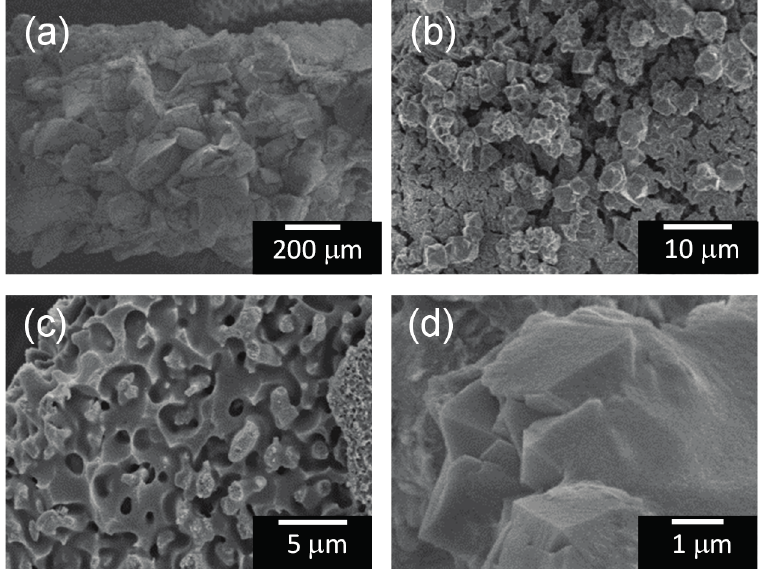
Figure 4. FE-SEM images of the TiO 2 -coated zeolite-porous glass composite: ( a ) low magnification image; ( b ) precipitated zeolite particles; ( c ) micro pores formed on the glass surface; and ( d ) TiO 2 coating layer on the